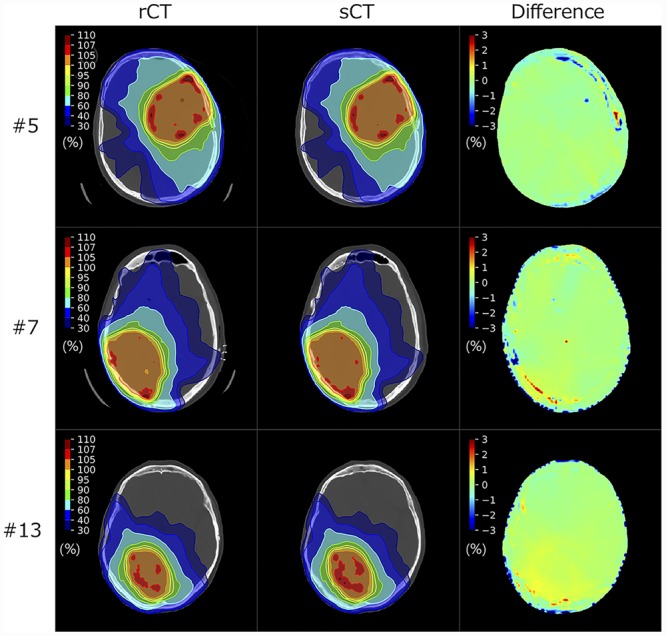
Dose distributions of sCTmulti of representative VMAT plans and associated difference maps showing the dose difference relative to the prescribed dose of 60 Gy. Each row shows the same slices as in Fig. 5.